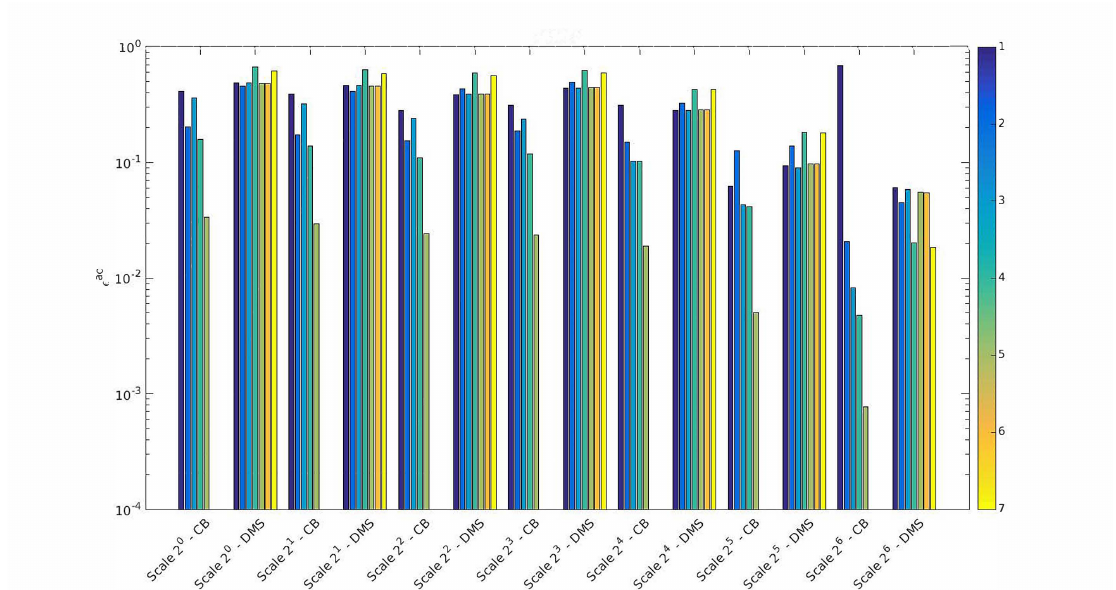
Figure 8. Values of (cid:101) ac for µ = 0.8—vertical planes. Definition of the color bar for “Scale 2 j —CB”: 1 → γ = 0.5, 2 → γ = 1, 3 → γ = 1.25, 4 → γ = 1.5, 5 → γ colora = 2.5; definition of color bar for “Scale 2 j —DMS” : 1 → N DMS = 50, 2 → N DMS = 100, 3 → N DMS = 150, 4 → N DMS = 220,